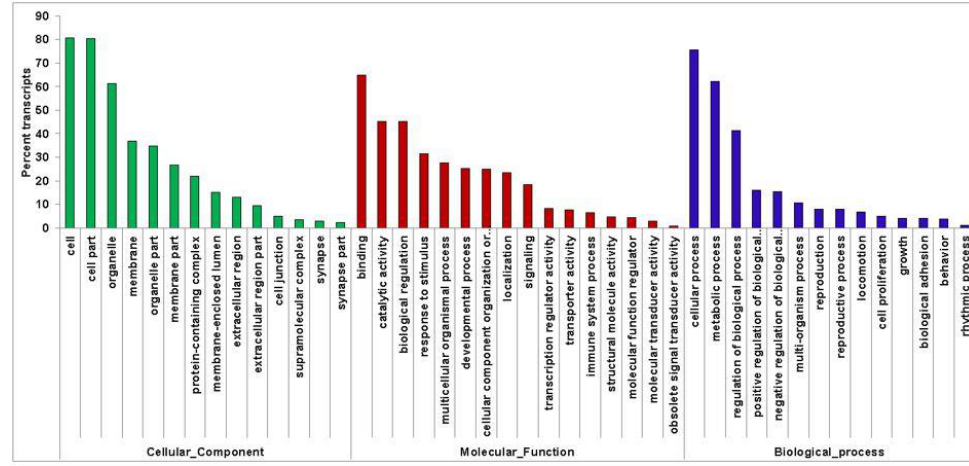
Figure 3. Gene Ontology (GO) classification of assembled transcripts from the GO-BLASTp result obtained from annotation using Trinnotate. The percentage of transcripts is represented on the y -axis for each GO class represented on the x